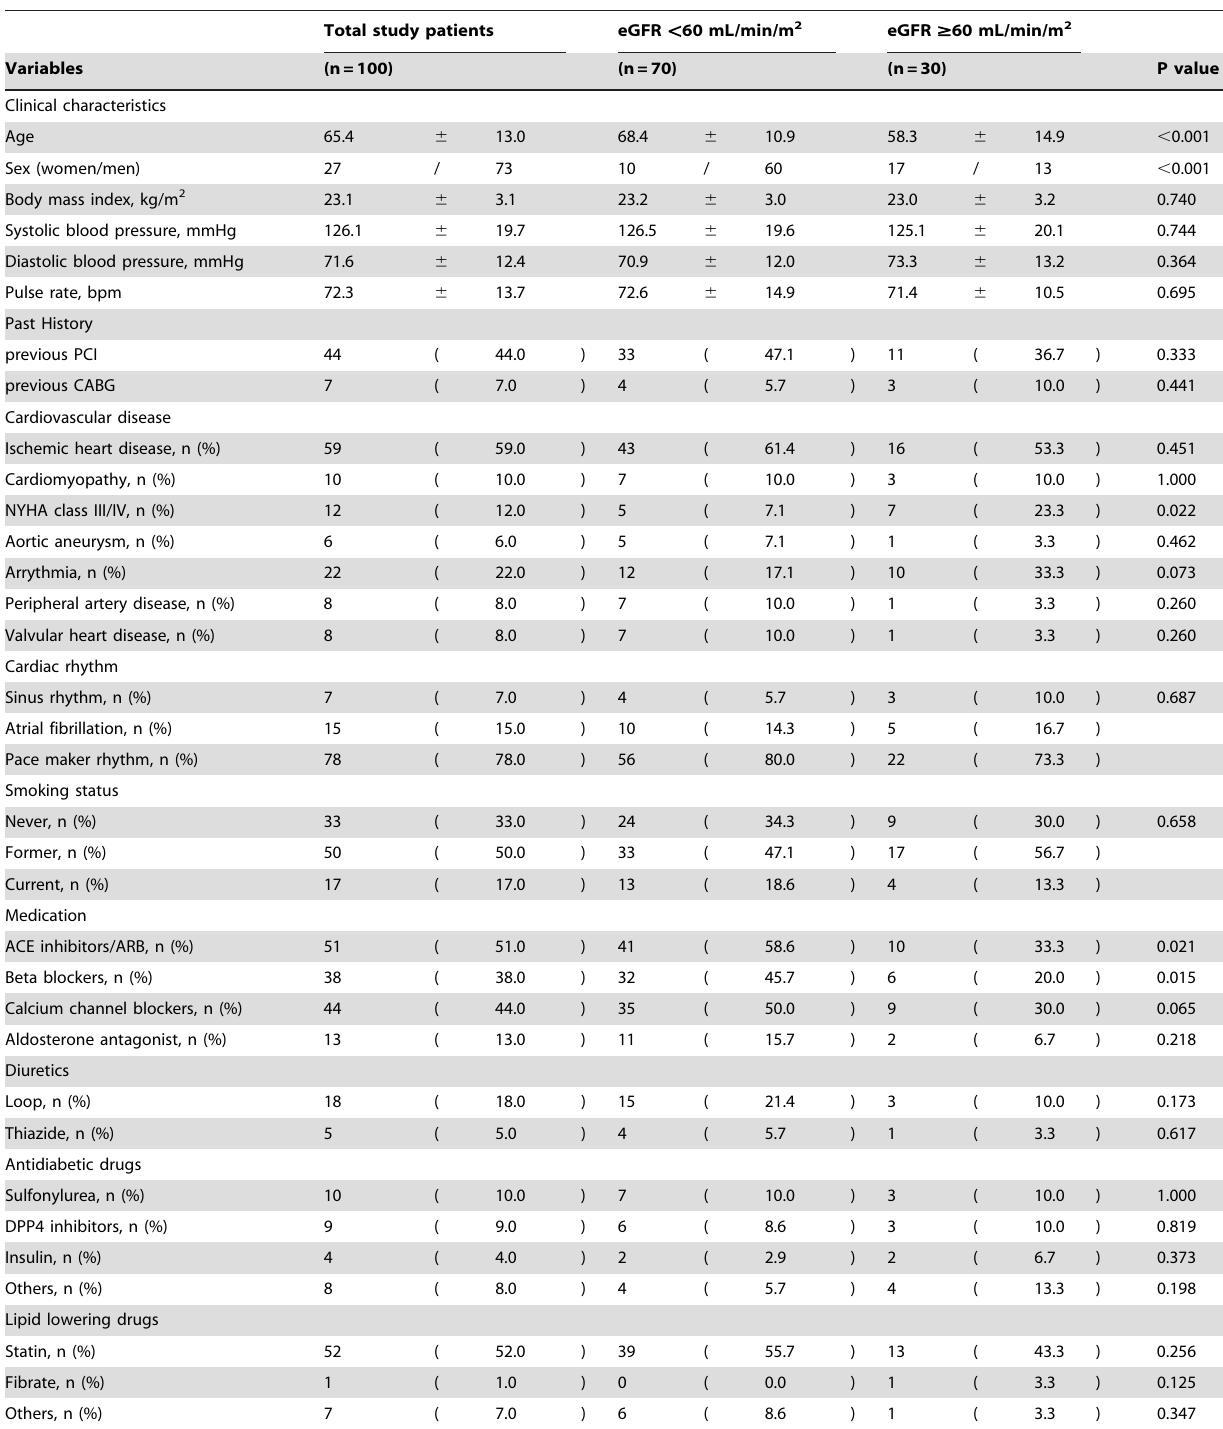
Table 1. Demographic characteristics of the study